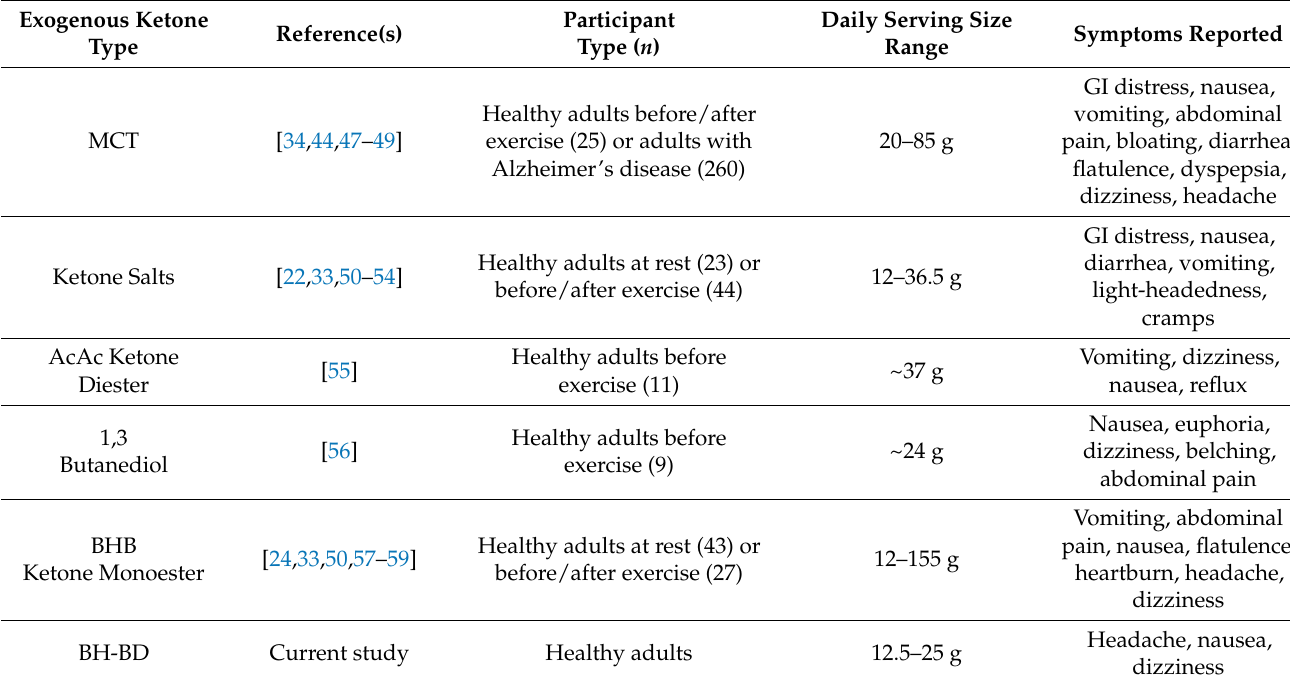
Table 7. Overview of reported gastrointestinal symptoms in studies of different exogenous ketone